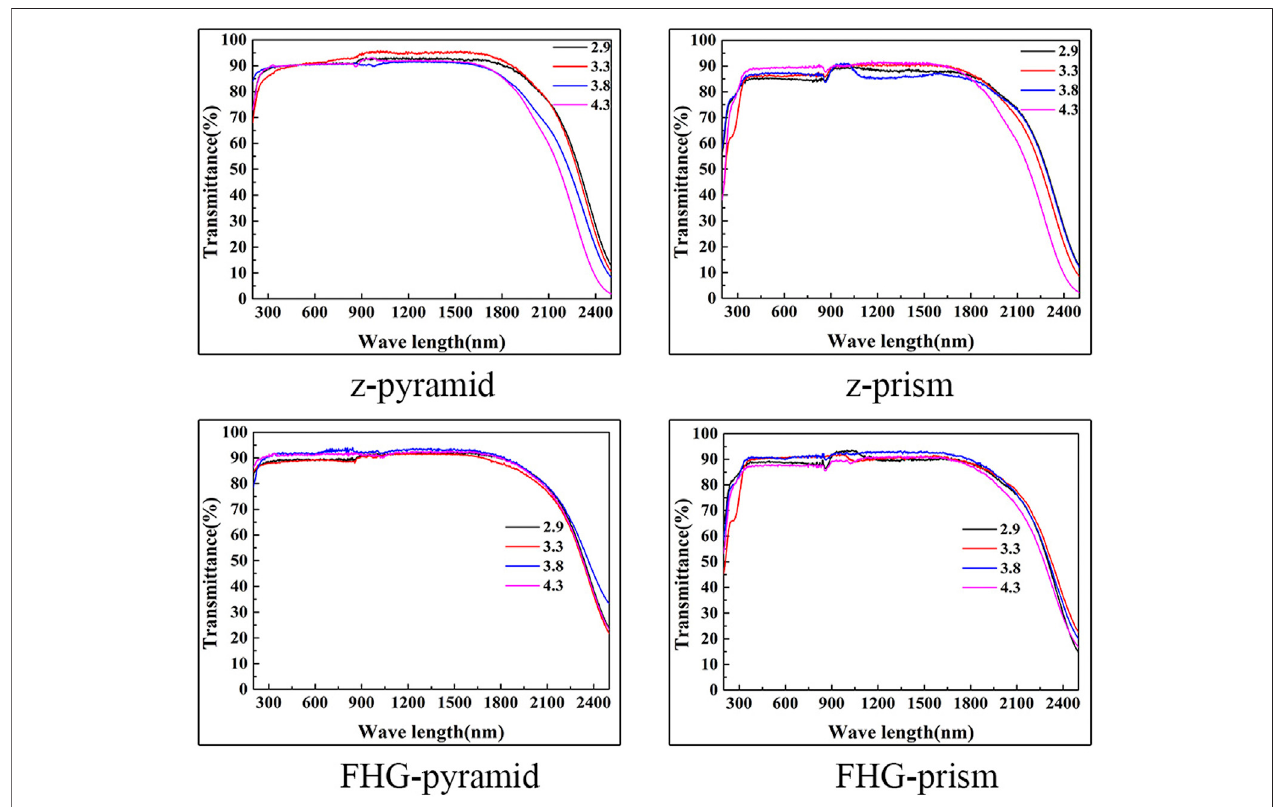
FIGURE 6 | The transmittance spectra of samples.